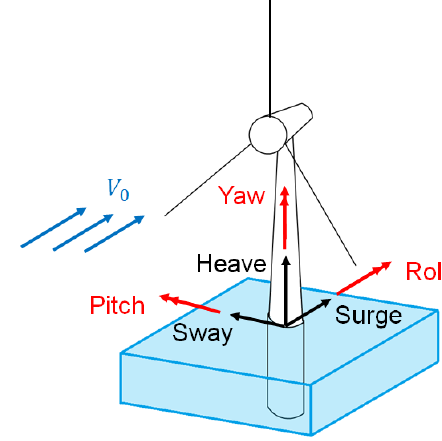
Figure 1. Sketch of the 6 degrees of freedom of a FOWT.